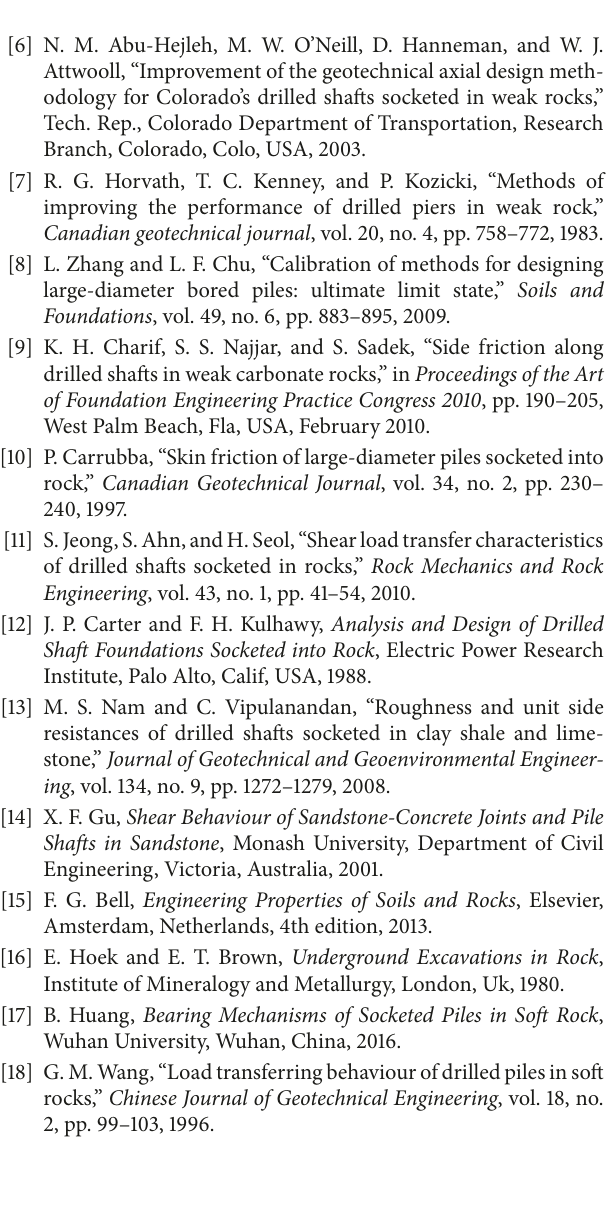
Figure 13: Failure status of simulated soft rocks after testing.